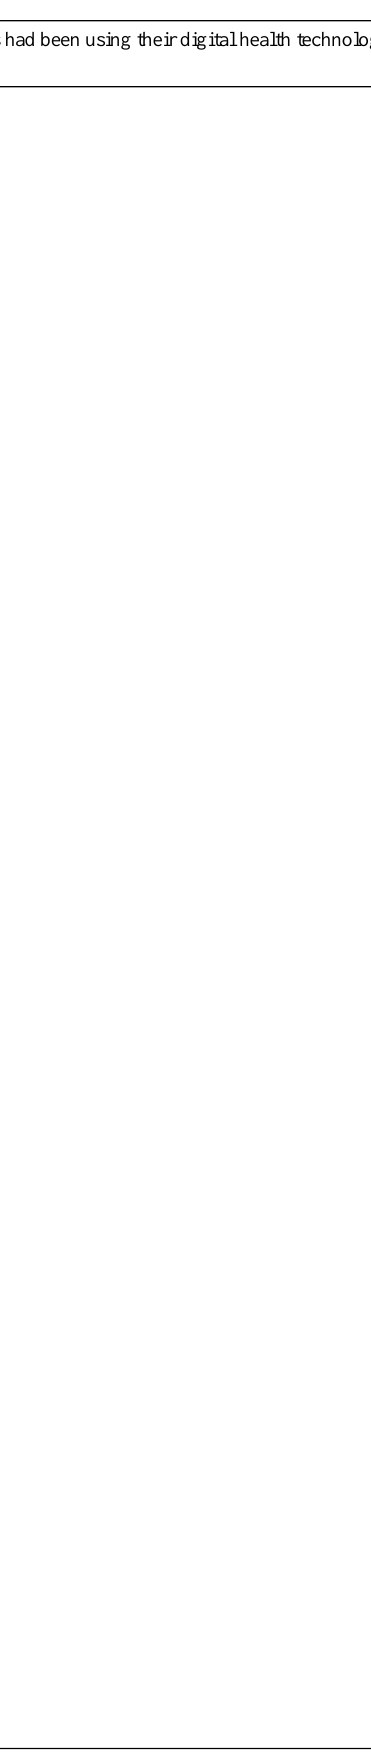
Table 1. Participant details for sample 1 and sample 2.